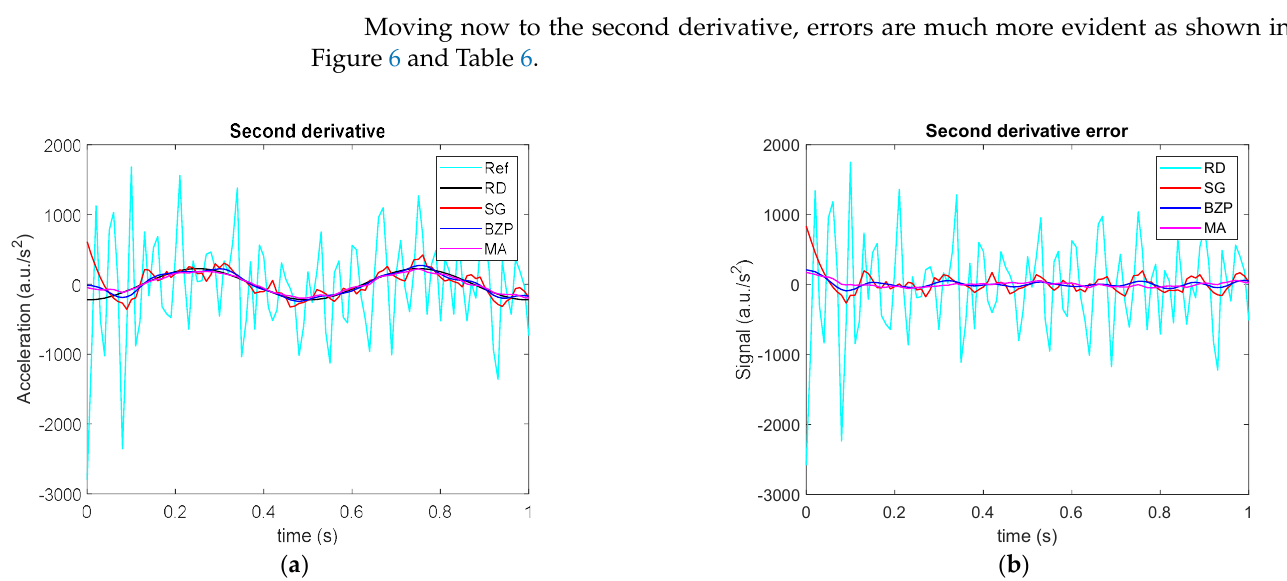
Figure 6. Signal double differentiation. ( a ) Time histories for analytical signal second derivative (Reference, Ref), numerically differentiated signal (raw differentiation, RD), differentiated and filtered by polynomial (SG), Butterworth (BZP) or moving average (MA), and ( b ) the second derivative errors for all the methods.